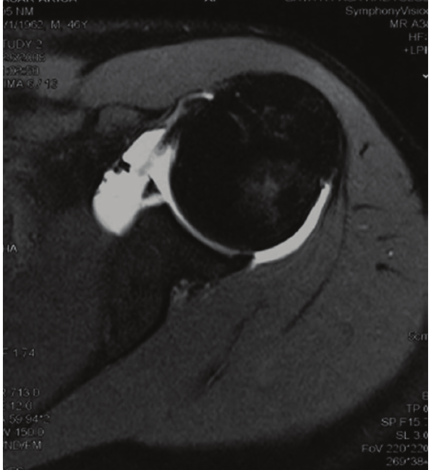
Figure 1: Bankart lesion.